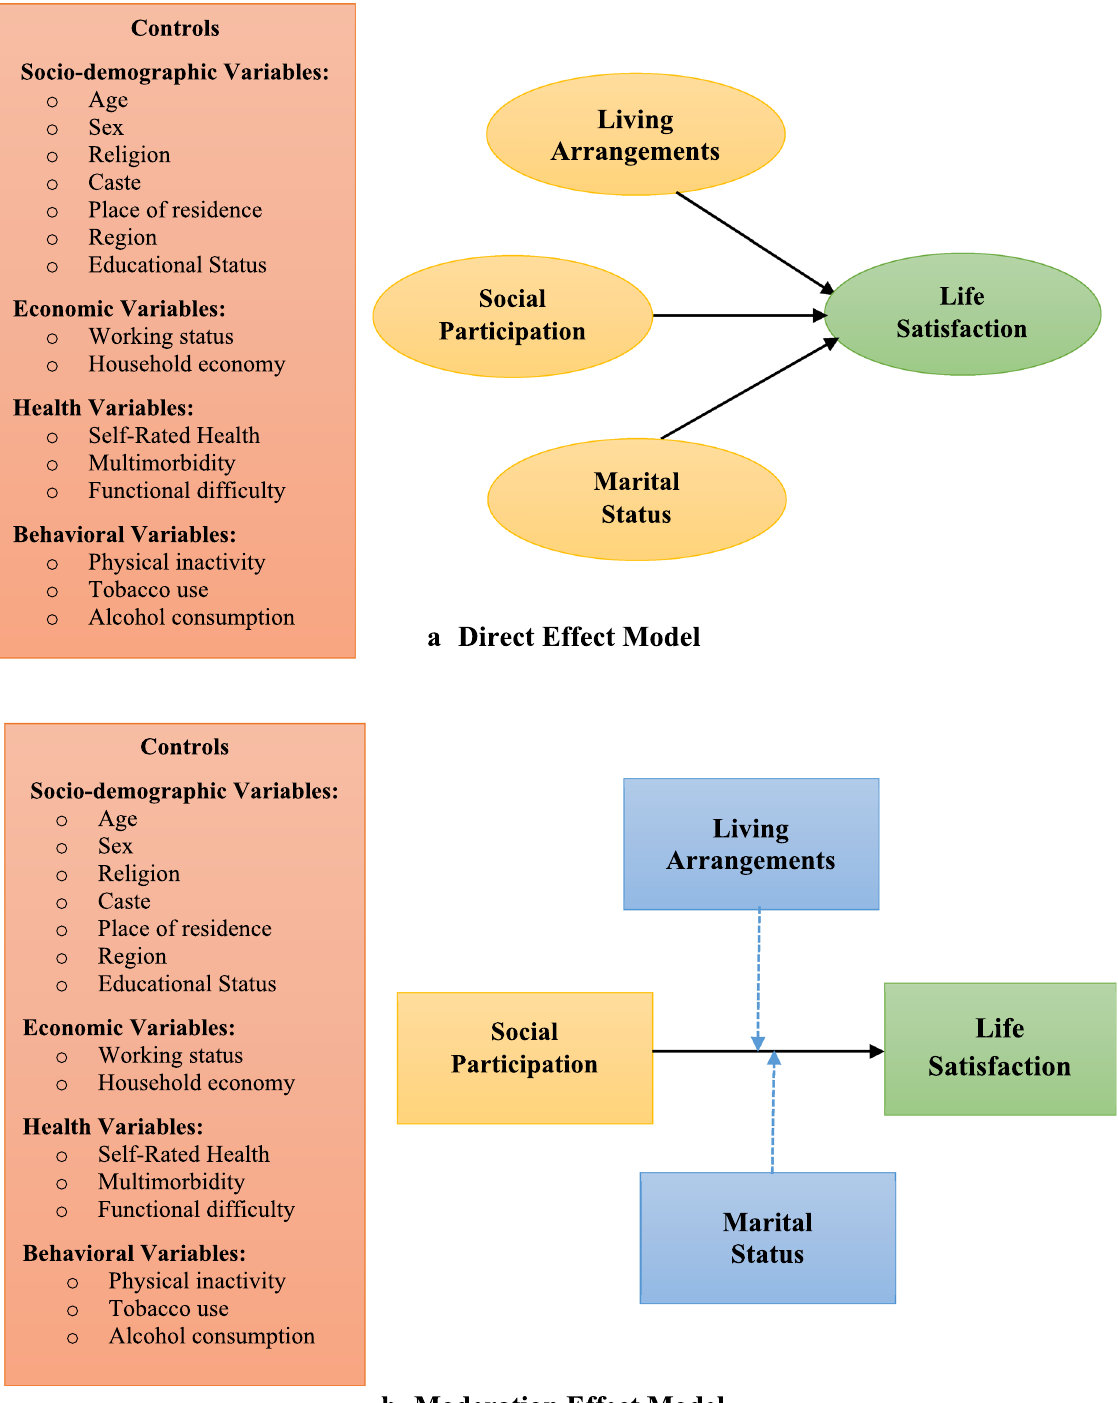
Figure 1. Model ( a ) Direct effect of social participation, marital status and types of living arrangements on Indian older adults’ life satisfaction Model ( b ) Moderation effect of social participation with marital status and types of living arrangements on Indian older adults’ life